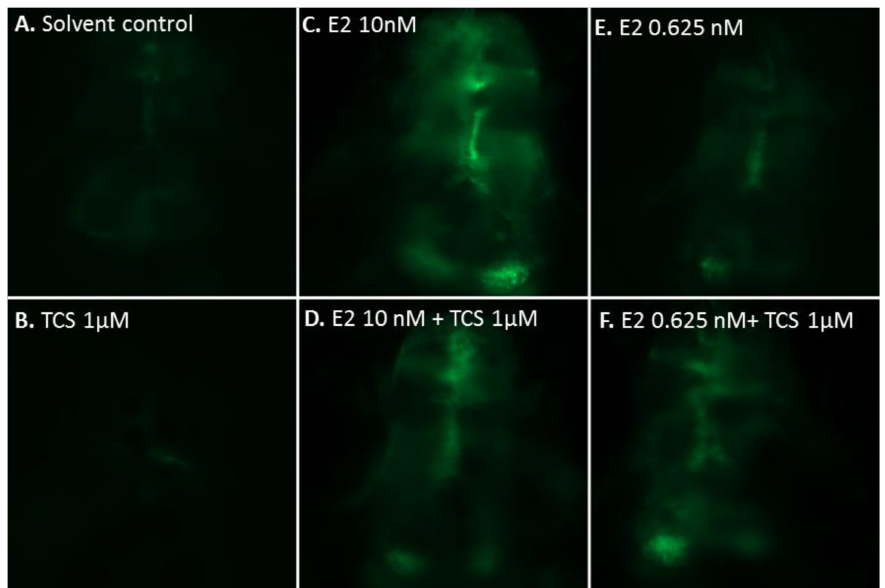
Figure 3. Dorsal view of the developing brain showing in vivo GFP expression (green signal) in the radial glial cells (RGCs) of transgenic cyp19a1b-GFP zebrafish (zf) embryos (4-dpf old) exposed to ( A ) solvent (DMSO); ( B ) TCS (1 µ M); ( C ) and ( E ) E2 (10 nM and 0.625 nM); and ( D , F ) E2 + TCS for 96 h.